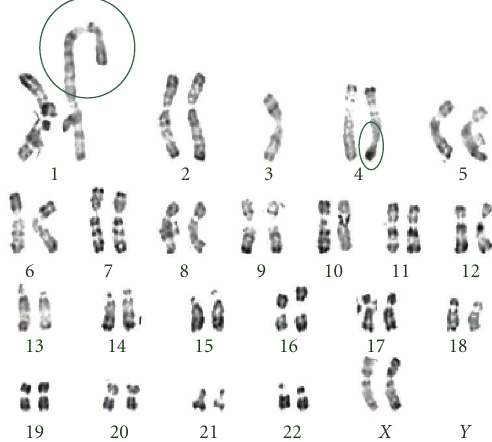
Figure 3: Karyotype of KAL0501 at passage P20. At this passage, two abnormalities are observed: an unbalanced translocation 4q32 and duplication 1q, or a translocation 1q with another